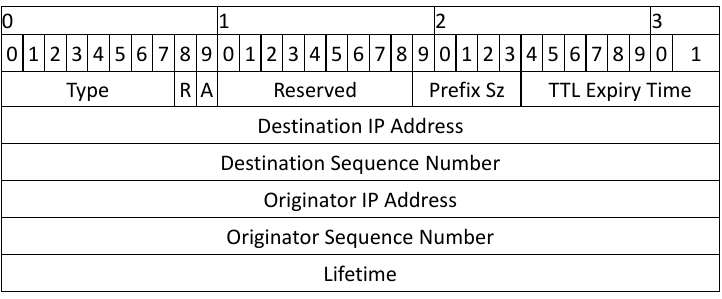
Figure 4. Packet Formats for